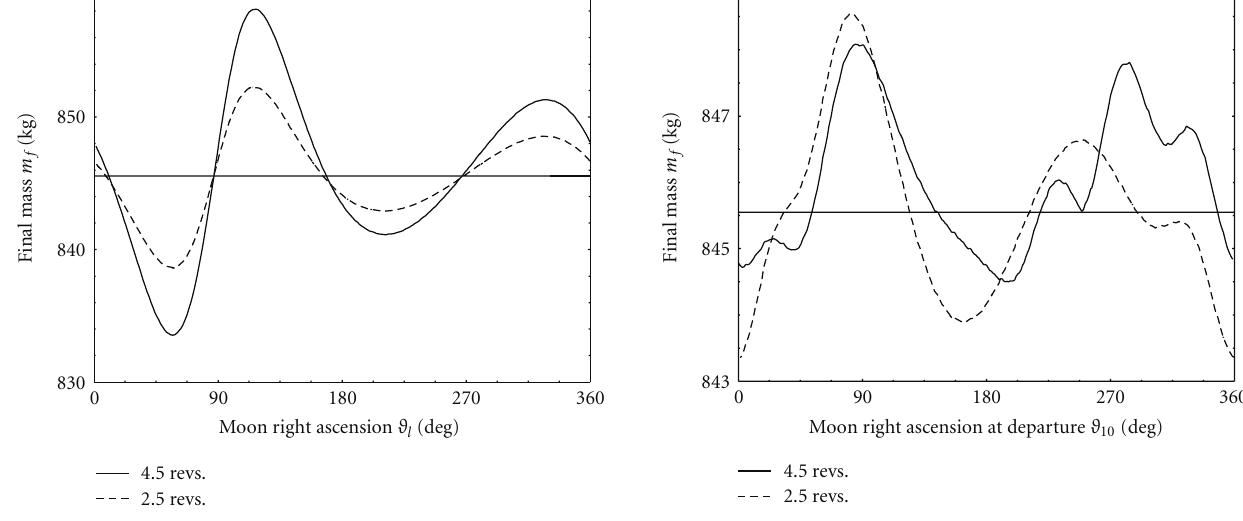
Figure 9: Final mass as a function of the Moon fixed position for 2.5- and 4.5-revolution 8N transfers (Sun neglected).